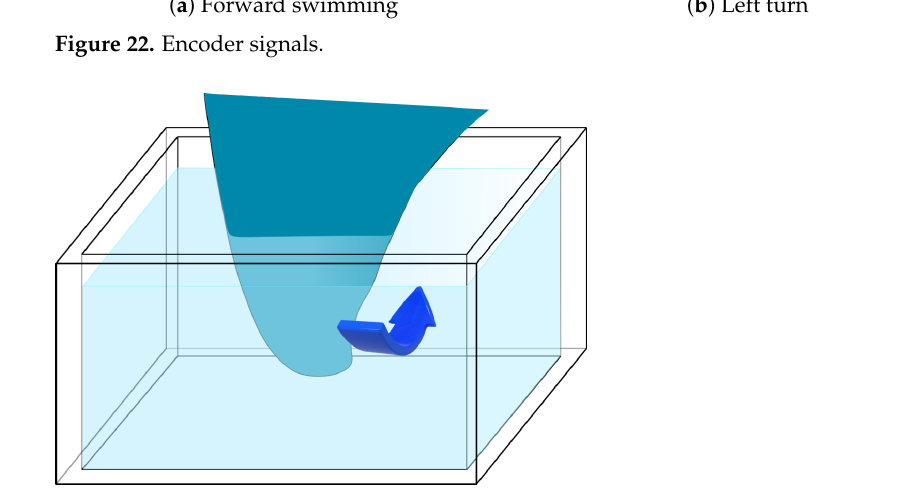
Figure 23. Scheme of the experimental